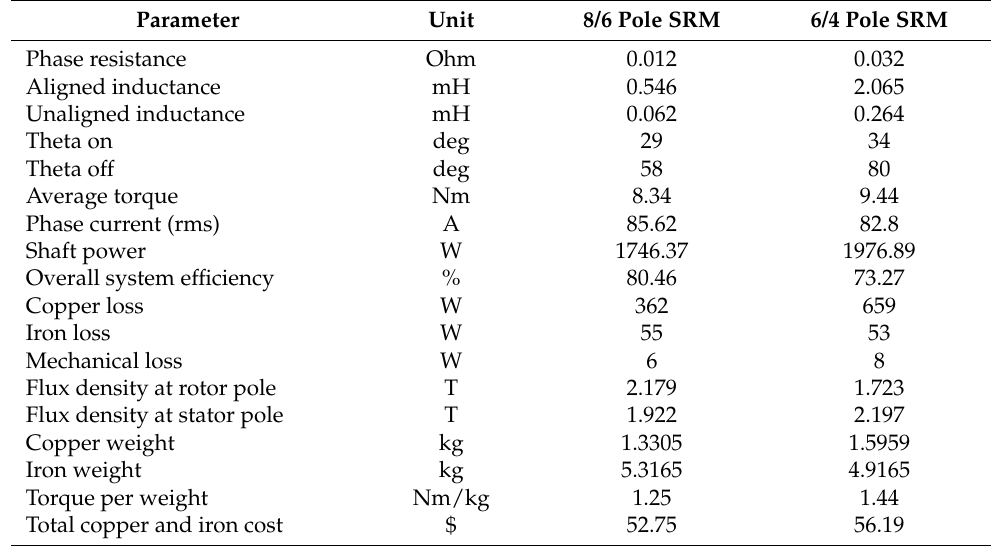
Table 4. Preliminary result of the four-phase 8/6 pole and three-phase 6/4 pole SRM at 2000